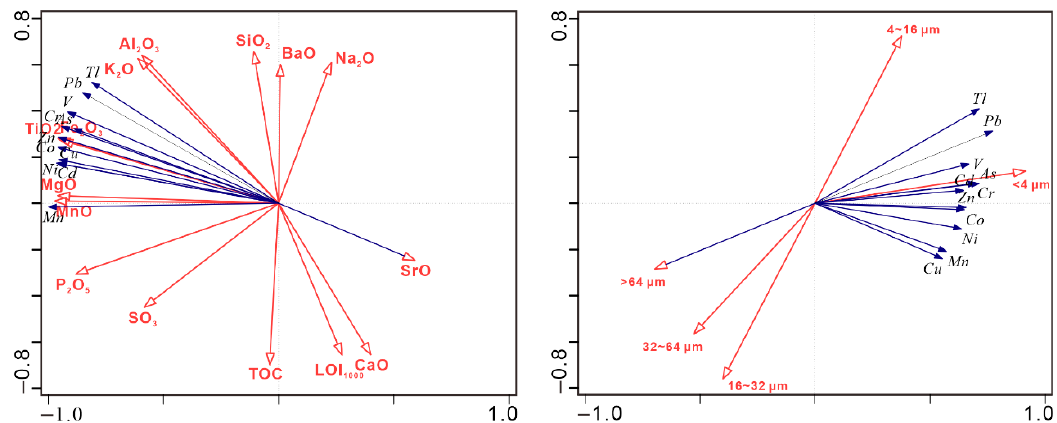
Figure 7. Redundancy analysis of the correlation among the potentially-toxic elements, bulk-rock composition, total organic carbon (TOC), and components of the different grain sizes. For the left-hand diagram, the two axes account for 99.95% of total eigenvalues (axis 1: 99.38% and axis 2: 0.57%) with permutation test results (pseudo-F = 134, P = 0.002). For the right-hand diagram, the two axes account for 99.98% of total eigenvalues (axis 1: 98.86% and axis 2: 1.12%) with permutation test results (pseudo-F = 2.9, p = 0.052).